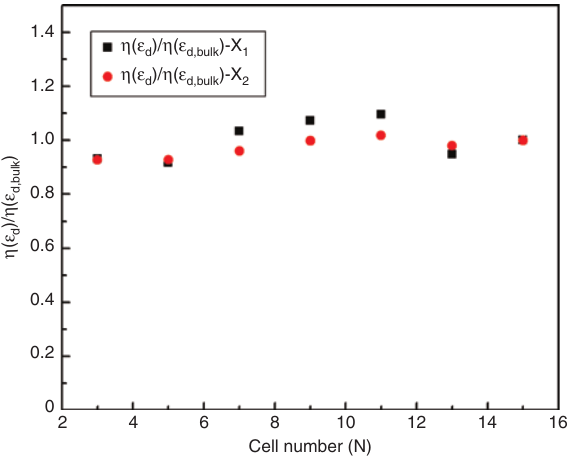
Figure 11 The energy absorption efficiency of honeycomb specimens compressed in in-plane direction, plotted against cell number, N .